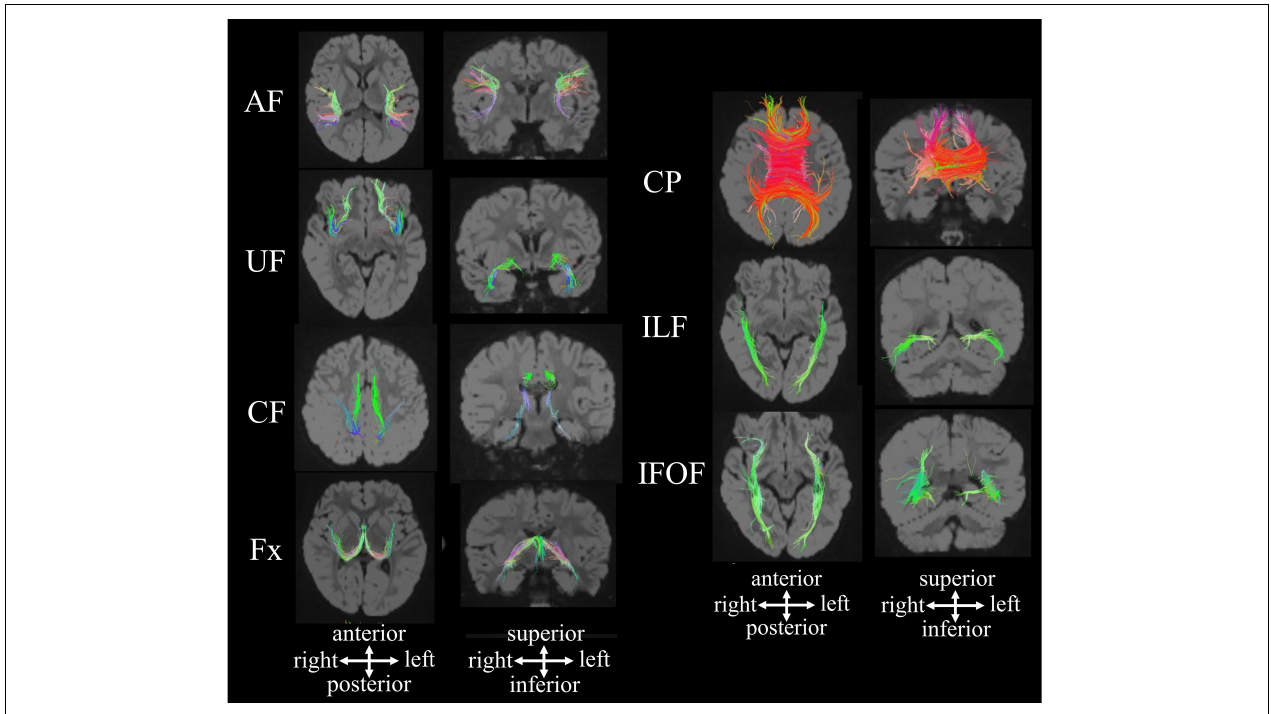
FIGURE 1 | HARDI-based tractography showing the callosal pathway and long association fibers in a 2.5-year-old neurotypical girl [reproduced with permission to reuse after minor revisions (Shiohama et al., 2020)]. AF, arcuate fasciculus; CF, cingulum fasciculus; CP, callosal pathway; Fx, fornix; IFOF, inferior fronto-occipital